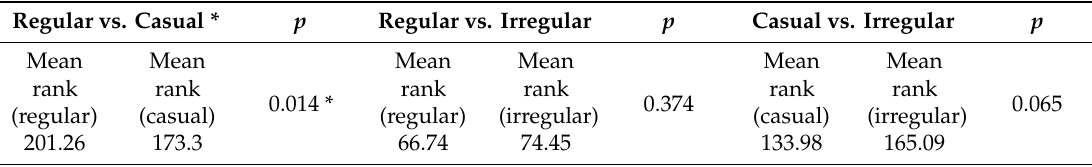
Table 7. Mann-Whitney analysis shows that the di ff erences in satisfaction with life wellbeing between the di ff erent categories of organic food buyers.